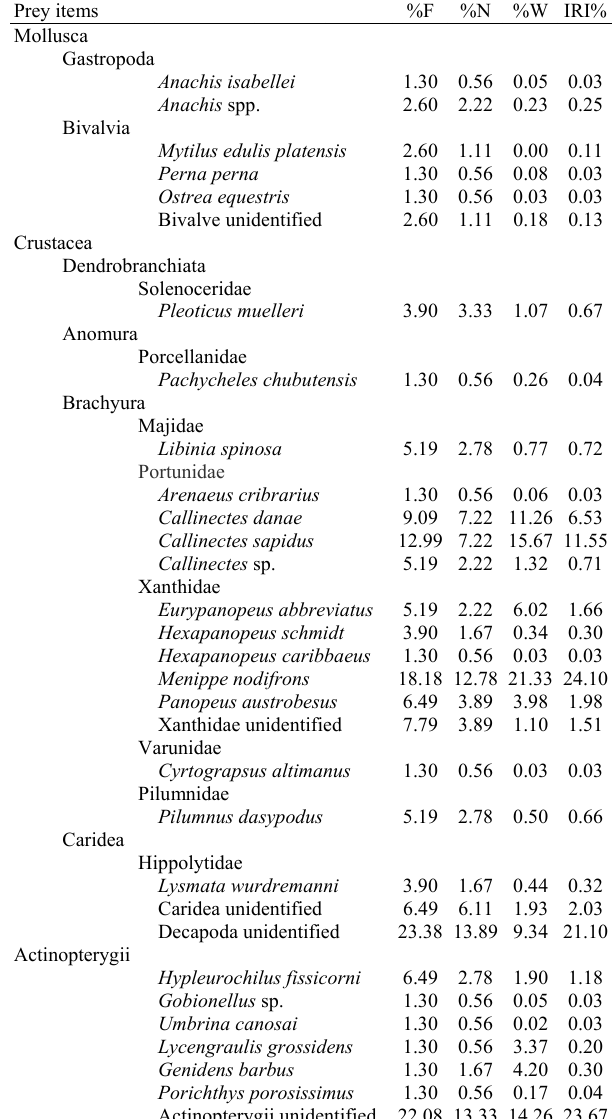
Table 1. Numerical abundance (%N), weight (%W), frequency of occurrence (%F) and the Index of Relative Importance (IRI%) for each food item found in the stomach content of the dusk grouper Mycteroperca marginata individuals captured. N = 78 non-empty